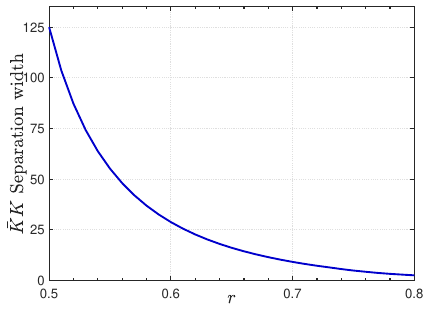
Figure 11 . Large kink-antikink collision: average width value of the more external small antikink- kink